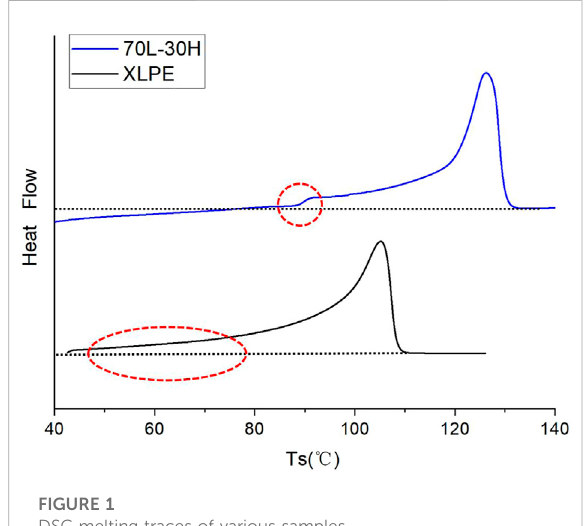
FIGURE 1 DSC melting traces of various